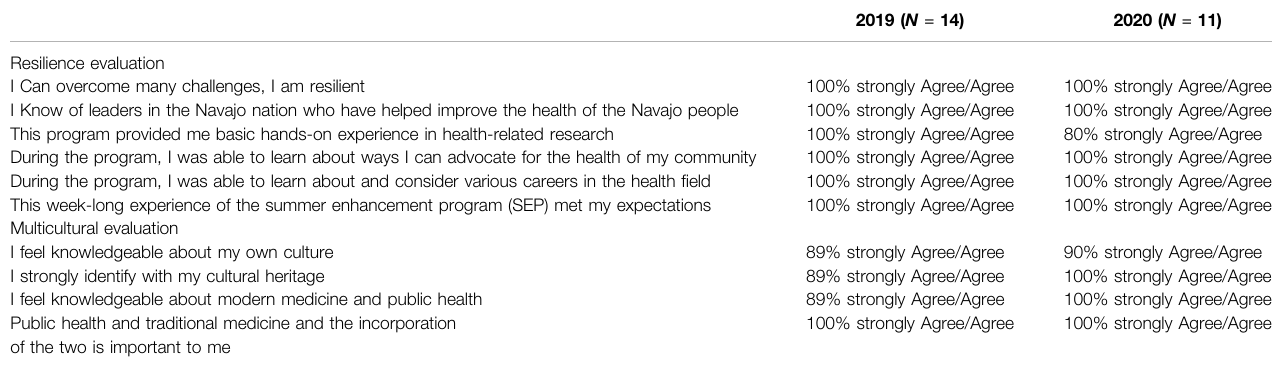
TABLE 6 | Evaluation results for 2019 and 2020 Indigenous Summer Enhancement Program resilience